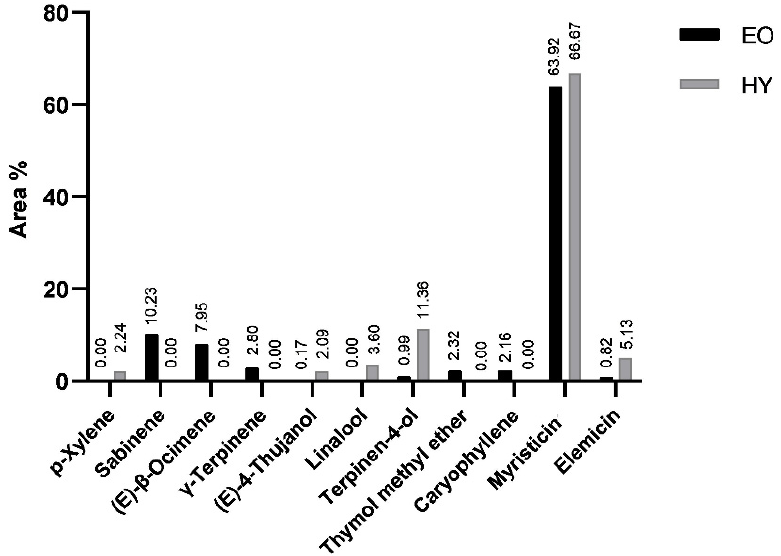
Figure 2. The most abundant compounds in air-dried P. ramosissima samples obtained by hydrodistillation and analyzed by gas chromatography–mass spectrometry. EO—essential oil; HY—hydro- sol.